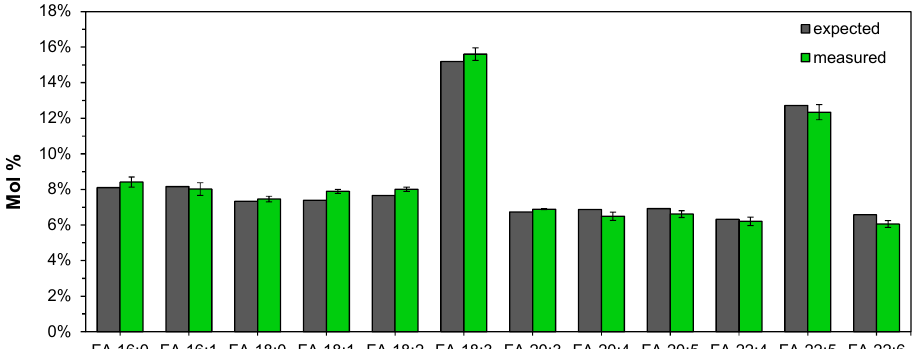
Figure 2. Instrument response for detection of deprotonated fatty acyl (FA) analytes is independent of chain length and number of double bonds. A standard mixture with 14 different NEFA species present in equal amounts (where FA 18:3 and FA 22:5 are present as two isomers, 18:3n − 3 and 18:3n − 6, and 22:5n − 3 and 22:5n − 6, respectively), was subjected to acid-catalyzed hydrolysis using H 218 O and Fourier transform mass spectrometry (FTMS). Data represent average ± SD ( n = 3).